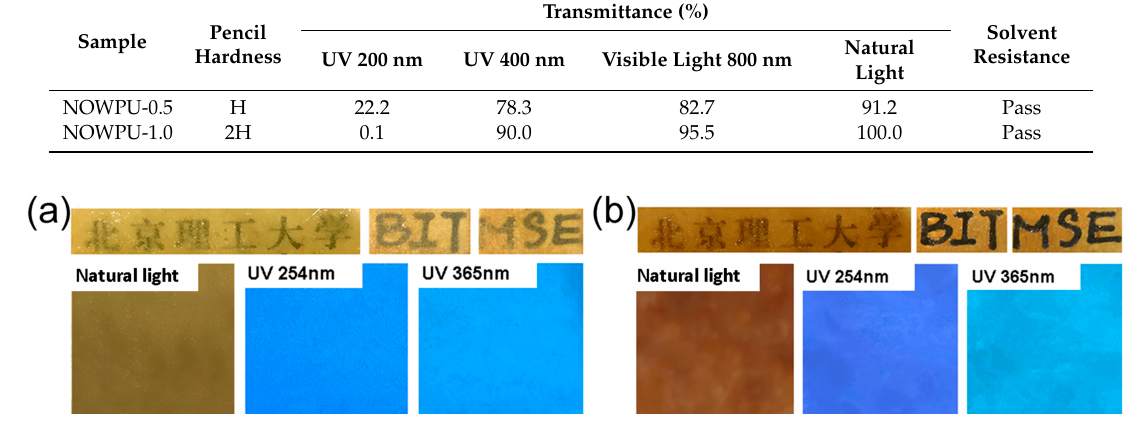
Figure 9. Coating films radiated by UV and natural lights: ( a ) NOWPU-0.5; ( b ) NOWPU-1.0.